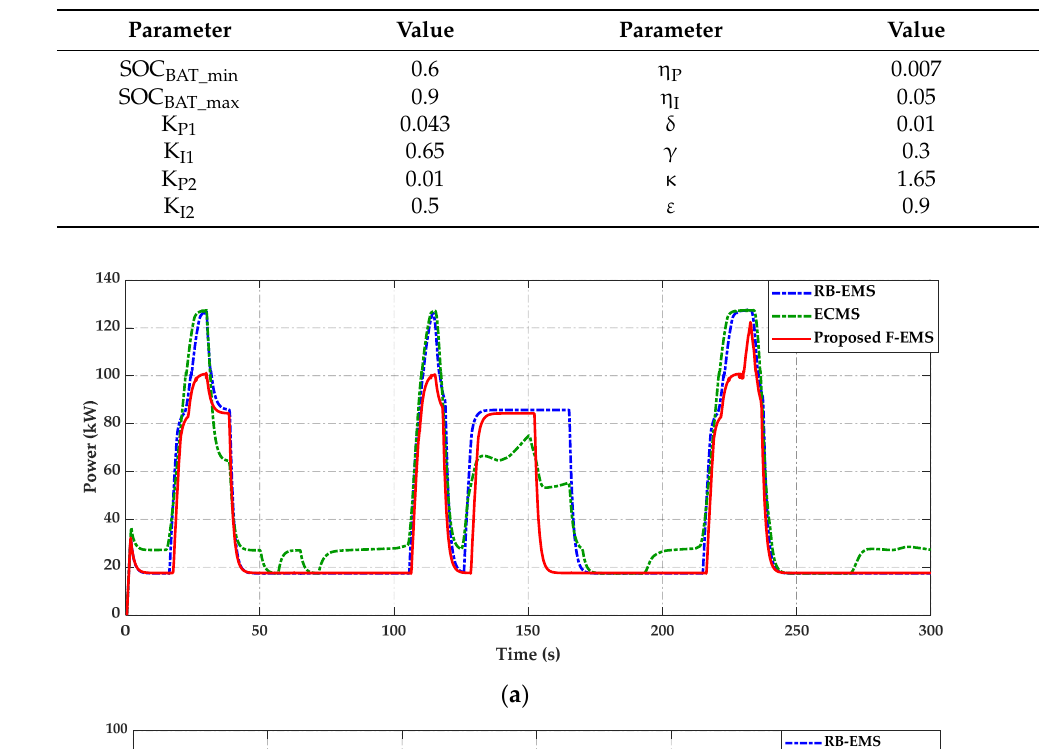
Table 5. EMS strategy parameters.